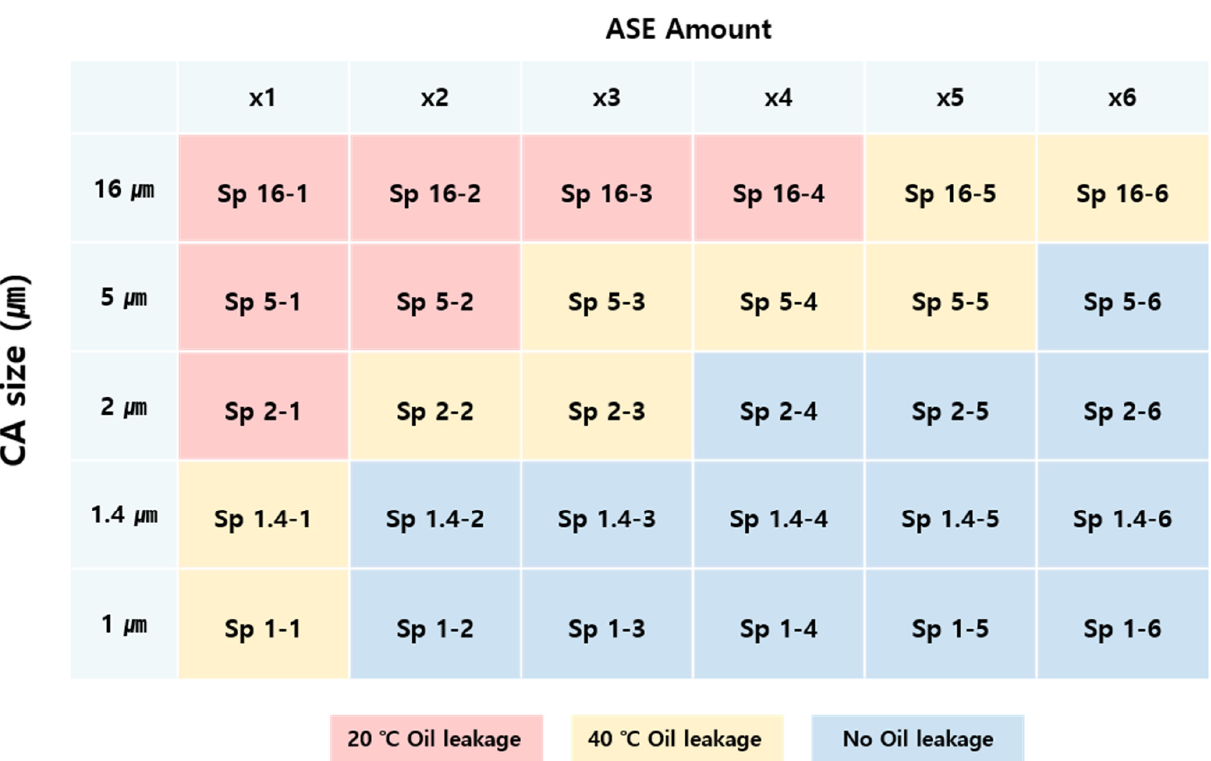
Figure 11. Comparison of oil leakage stability characteristics under temperature conditions according to ASE content by CA average particle size.